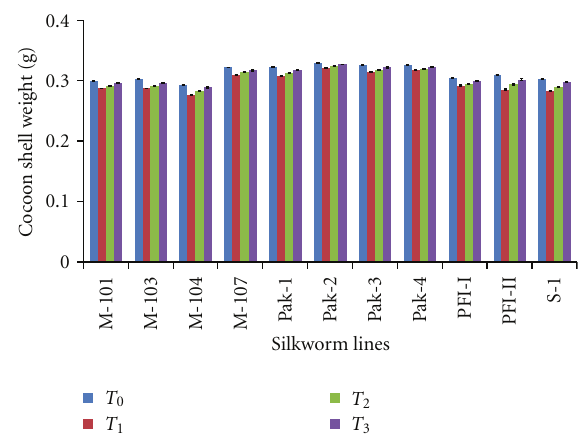
Figure 3: Comparative performance of cocoon weight (mean ± SE) eleven silkworm lines at 35 ± 1 ◦ C in combination with 55, 65, and 75% RH and controlled conditions of temperature and RH (25 ± 1 ◦ C and 70–80%, resp.).